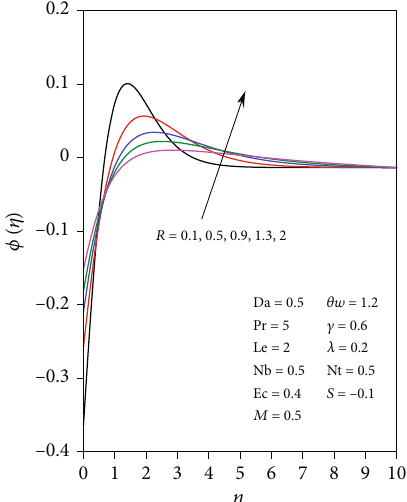
Figure 14: Concentration of nanoparticle pro fi le for di ff erent values of R